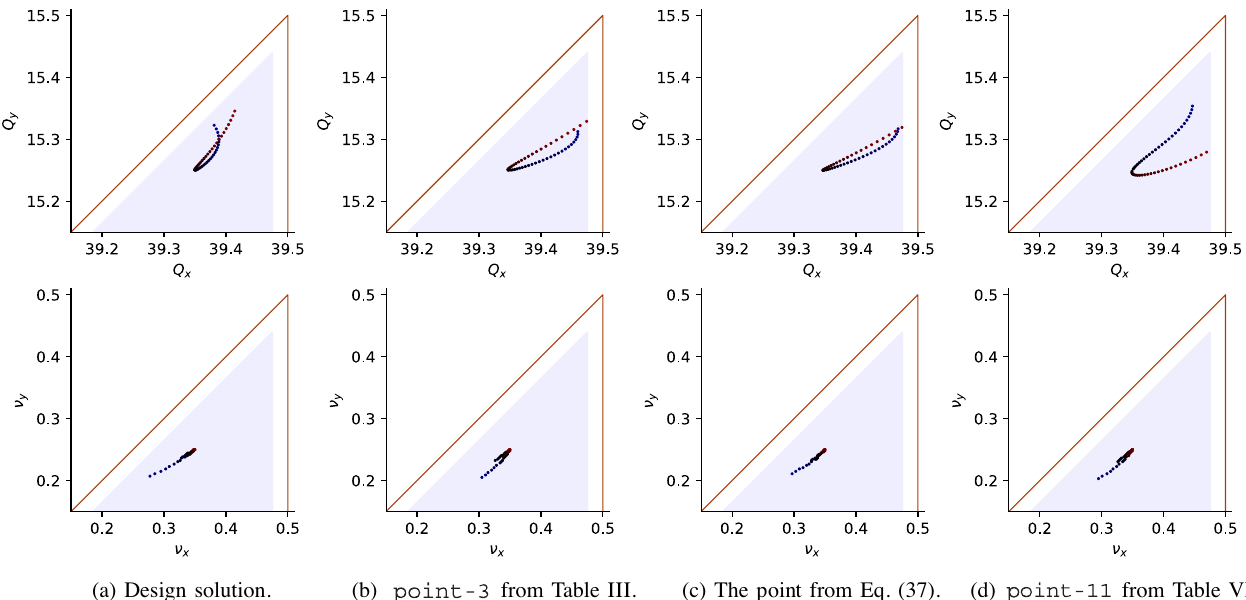
FIG. 7. Chromatic tune footprint in the range δ ∈ ½ − 0 . 05 ; 0 . 05 (cid:3) (top row) and amplitude-dependent tune footprint (bottom row) for the solution candidates: the manually obtained solution (referred to as the “ design solution, ” first column), point-3 from Table III (second column), the design point from Eq. (37) (third column) and point-11 from Table VI (fourth column). The first- and second-order resonances are shown as red and the blue triangle area includes the additional margin around the resonance lines. One of the goals of the optimization was to prevent the tune resonances from being crossed by constraining the tune footprints inside the triangle with margins (blue triangle). It can be seen that the definition of unstable ∓ , ctfp and adts in Sec. II B, as well as their treatment in the optimization problem formulation in Sec. II D successfully constrained the tune